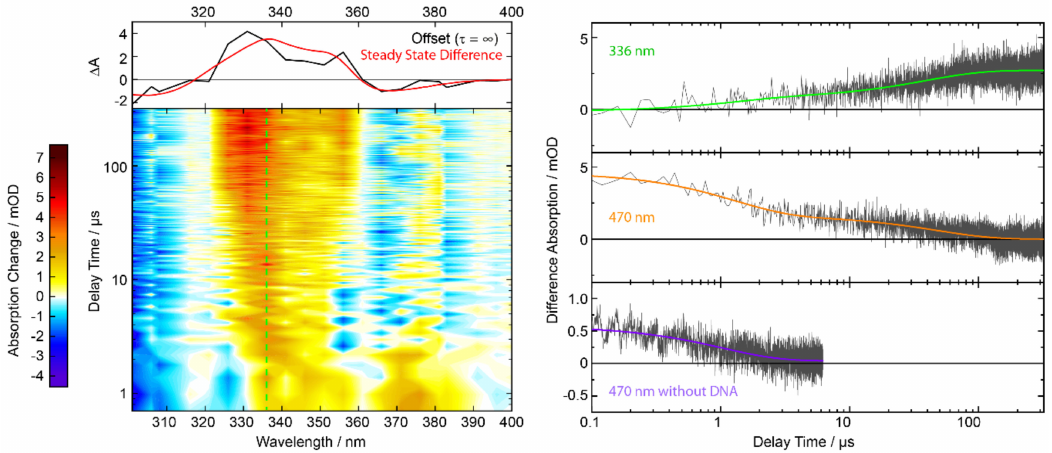
Figure 7. Nanosecond transient absorption of TMP (17 µ M) with AT-DNA (1.6 mM) in aerated bu ff er solution after excitation at 355 nm. Left: The transient absorption in the contour plot is color-coded. The green line marks the respective time trace (336 nm) shown on the right. On top is the o ff set spectrum in comparison with the steady-state signature (red, scaled to match the o ff set spectrum) after irradiation at 375 nm. Right: Time traces at 336 and 470 nm. The third time trace shows TMP (6 µ M) without DNA in water. The colored lines show bi-exponential (green and orange) or single exponential (violet) fits of the